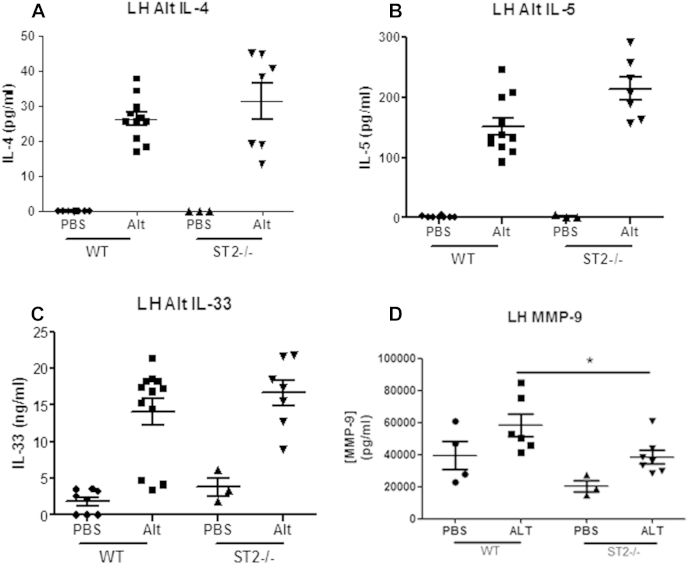
Neonatal ST2−/− and wild-type mice were exposed to intermittent intranasal A alternata (Alt; 5 μg for the first 2 weeks and then 10 μg) or saline (PBS) from day 3 of life for 3 weeks. Levels of IL-4 (A), IL-5 (B), IL-33 (C), and MMP-9 (D) were measured in lung homogenates (LH) by means of ELISA. Data are representative of 2 experiments (n = 6-8 per group). *P < .05.